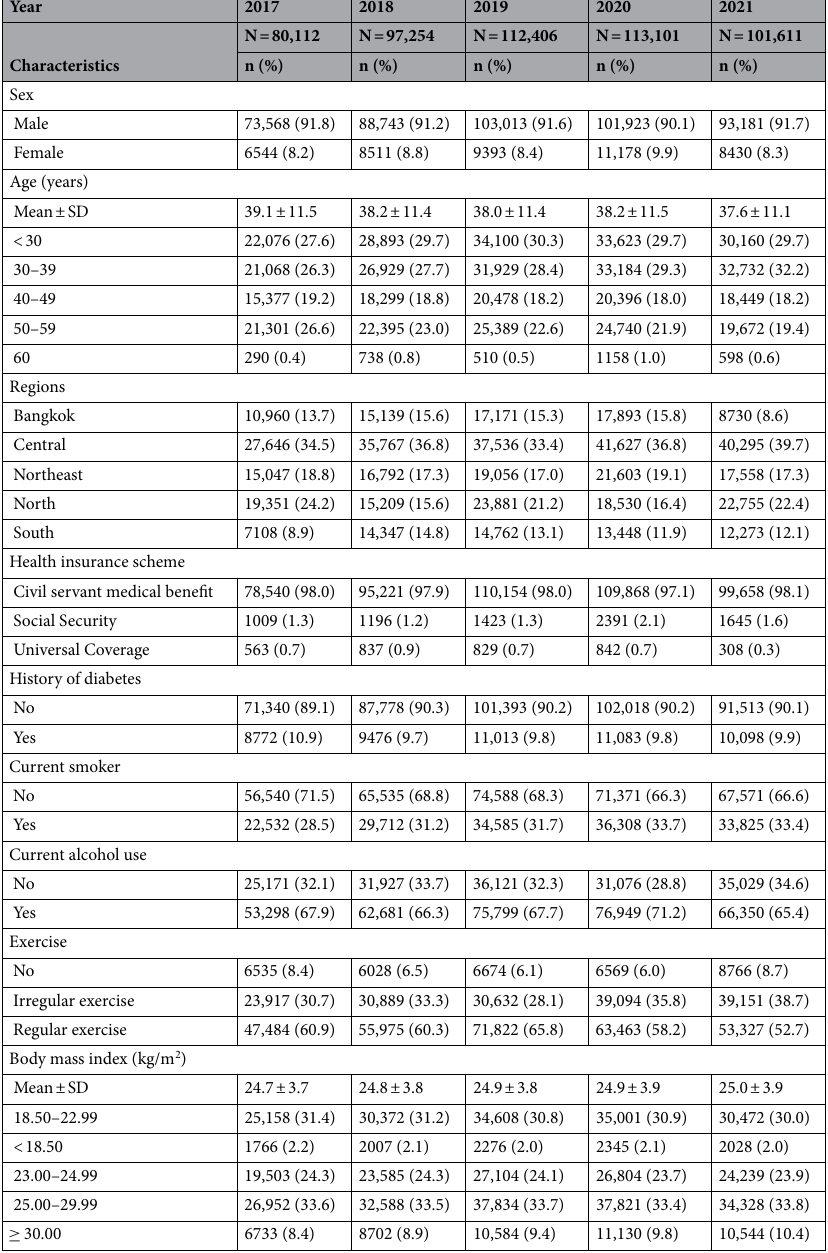
Table 1. Demographic characteristics of participants from 2017 to 2021 (N = 504,484). SD standard